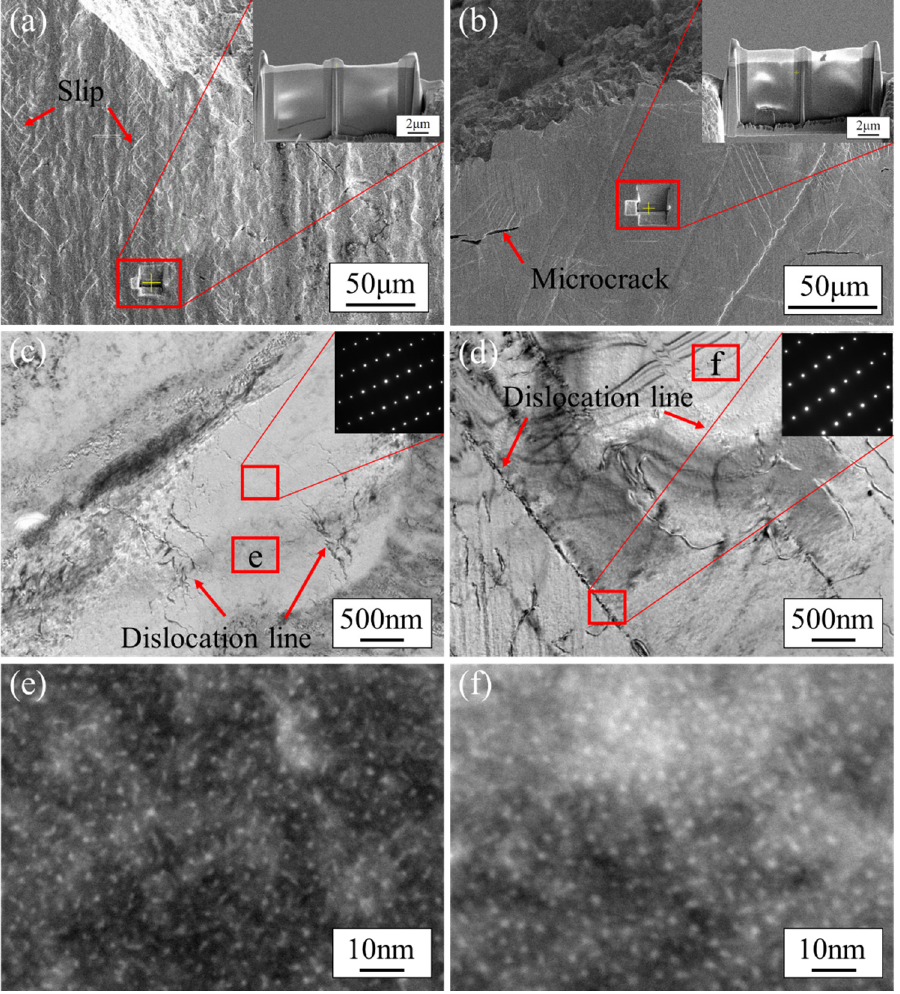
Figure 10. FIB cutting position and the cut specimen: ( a ) PO20 specimen, ( b ) PO60 specimen; the dislocation morphology in alpha-case of PO20 specimen ( c ) and PO60 specimen ( d ), and ( e , f ) the HADDF images of the corresponding areas in ( c , d ).